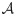
Modularity evolves after selection for an additional gene activity phenotype.(A) Target GAPs I and II. White and black squares represent active and inactive genes, respectively. Genes 1-5 are grouped in set A and genes 6-10 are grouped in set B. Note that genes in set A have the same activity state in both target GAPs. In contrast, genes in set B have a different activity state in both target GAPs. Networks evolve in a first stage under selection to produce target GAP I. In a second stage, selection favours networks that produce target GAPs I and II from distinct initial system states, that may occur, for example, in cells in different parts of an organism. (B) QPN increases after selection for an additional gene activity phenotype. Each dot represents an independently evolving population. The horizontal axis indicates the QPN score for a network with the highest fitness before starting selection for the two GAPs. The vertical axis denotes the same score but for a network after selection for both GAPs. The solid diagonal is the identity line. (C) After selection for GAP I alone, interactions between any pair of genes occur with similar frequency. Grayscale indicates the fraction of independently evolved networks that have a certain source-target regulatory interaction. (D) After selection for both target GAPs I and II interactions occur mainly either between genes in set A or between genes in set B.